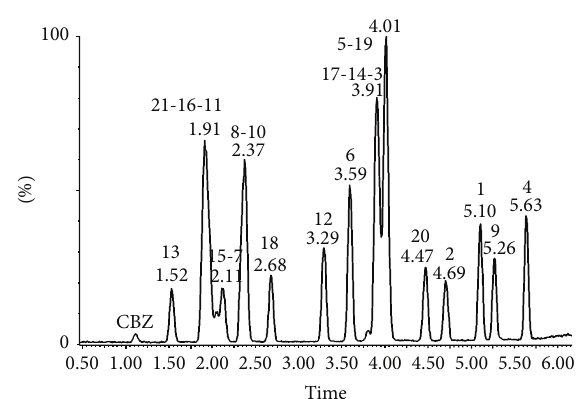
Figure 1: Example of chromatographic separation related to a single point of calibration curve (50 𝜇 g on wipe-test). Numbers on peaks identify glucocorticoids code as showed in Table